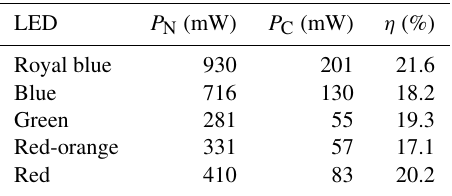
Table 2. LED total power, fiber-coupled power into a standard 1mm POF (NA = 0.5) and coupling efficiency of the measured LEDs (Wächter,